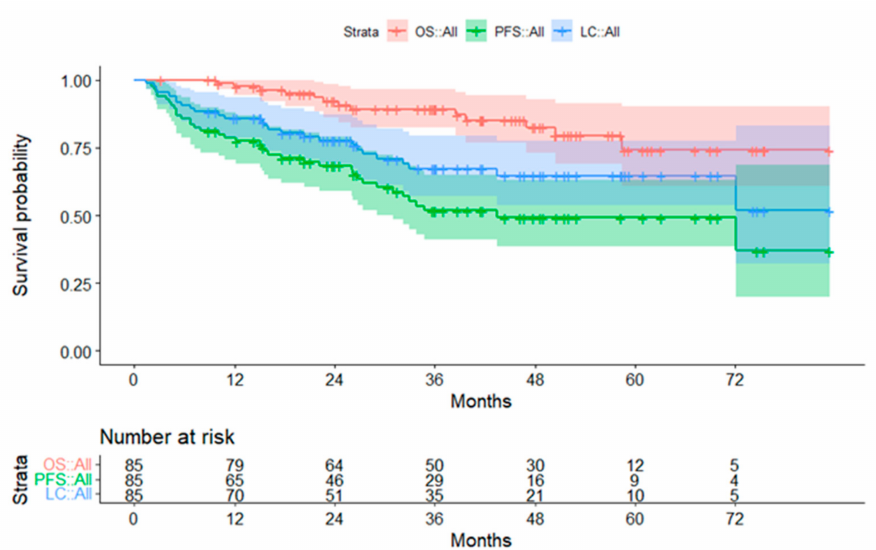
Figure 2. Survival curves for patients with ependymoma. The 95% confidence intervals are displayed. Abbreviations: OS = overall survival; PFS = progression-free survival; LC = local